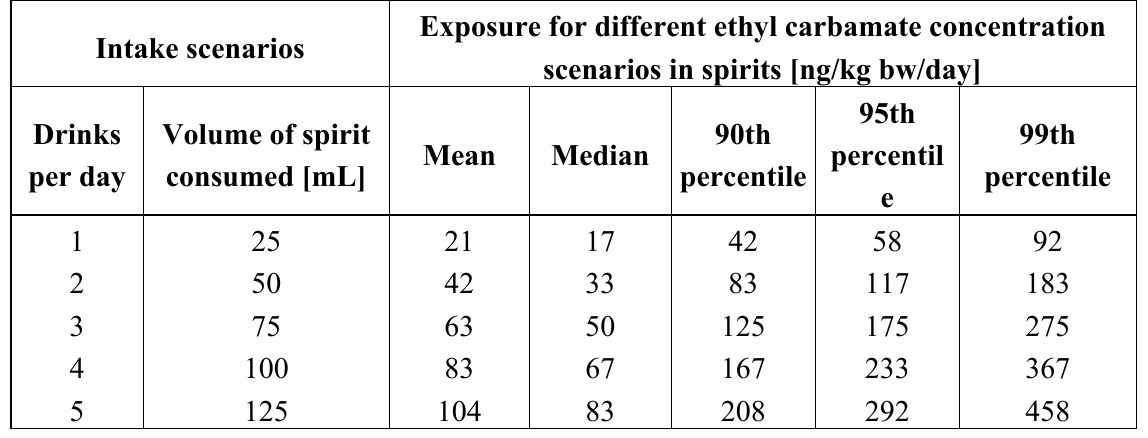
Table 4. Exposure to ethyl carbamate from agave spirits in Mexico (calculated for a 60 kg